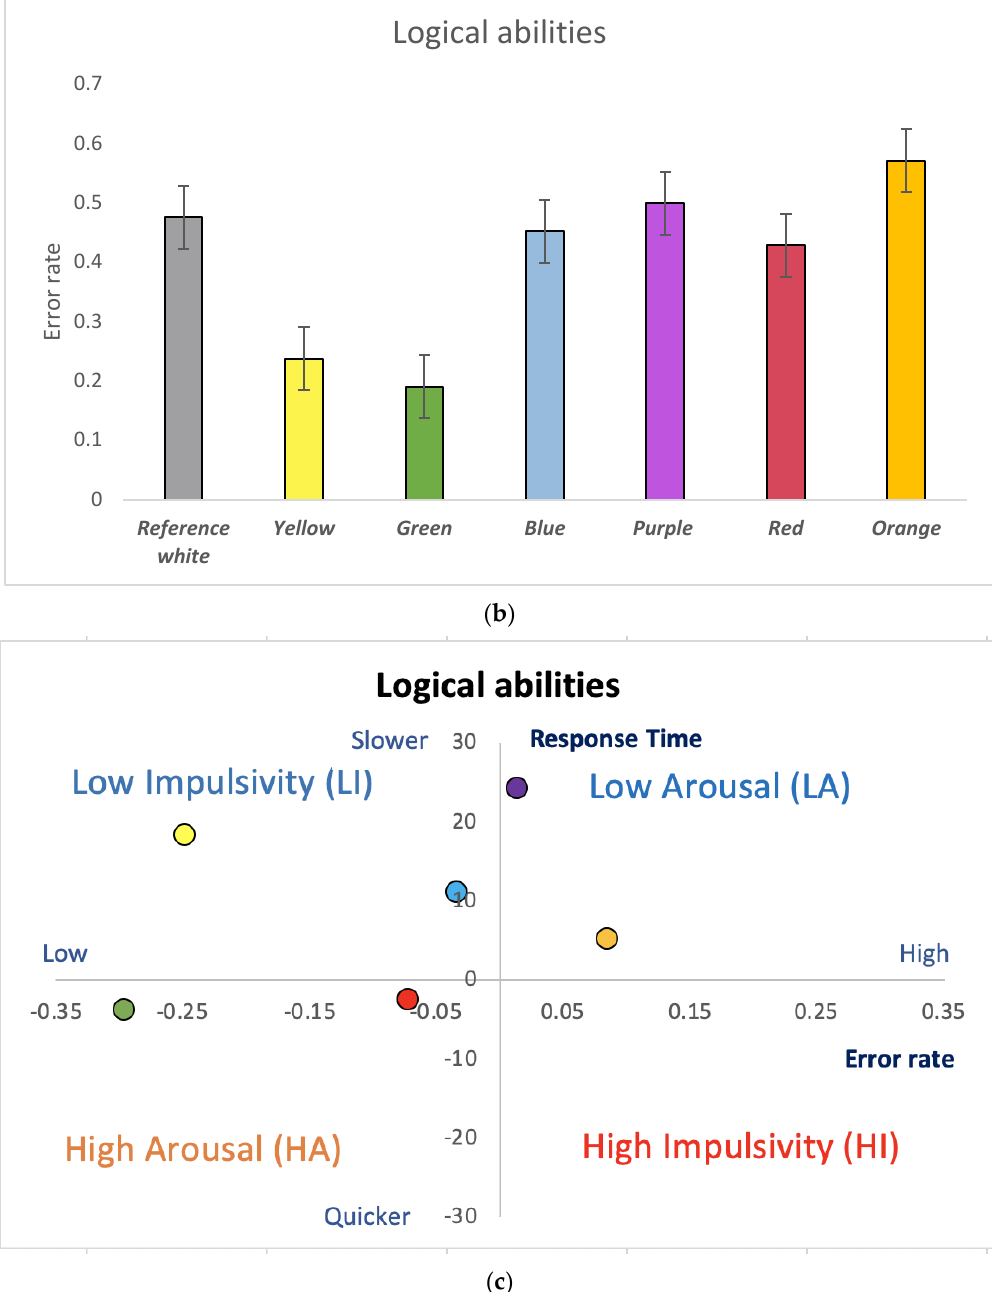
Figure 4. ( a ) Response time of participants’ performance in logical abilities by background colours; ( b ) Error rate of participants’ performance in logical abilities by background colours; ( c ) Colour impacts on logical abilities visualised in the Error-Speed space. The bars represent mean changes, while the error bars are the standard error of the mean across individual participants.